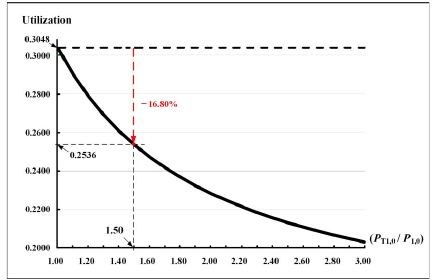
Fig. 11. The expedited ratio ( P T1,0 / P 1,0 ) effect on the Fig. 12. The impact on utilization relating to ( P T1,0 / P 1,0 ) optimal uptime t 0 * Fig.12 discloses the influence on utilization relating to the expedited ratio ( P T1,0 / P 1,0 ). At ( P T1,0 / P 1,0 ) = 1.5, the utilization E [ TCU ( T A *, n *)]. As both ( P T1,0 / P 1,0 ) ratio and mean x i rise, E [ TCU ( T A *, n *)] significantly surges. At ( P T1,0 / P 1,0 ) = 1.5, it